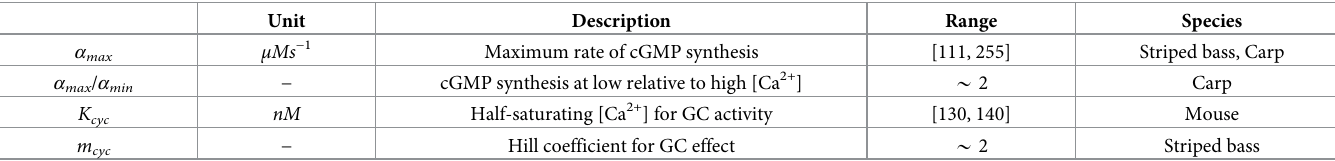
Table 4. Guanylyl cyclase (GC) activity parameters. α max is the maximum cGMP synthesis rate in the absence of Ca 2+ and α min is the synthesis rate at saturating Ca 2+ concentration. These activities were measured in the absence of bicarbonate.